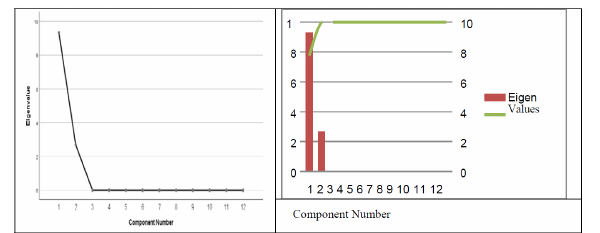
Figure 1: Plot of Components Vs Eigen Value